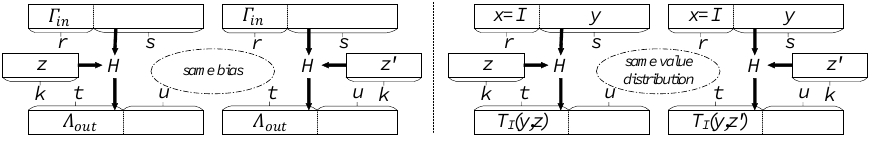
Figure 2: Equivalent between TDIB and Related-Tweak